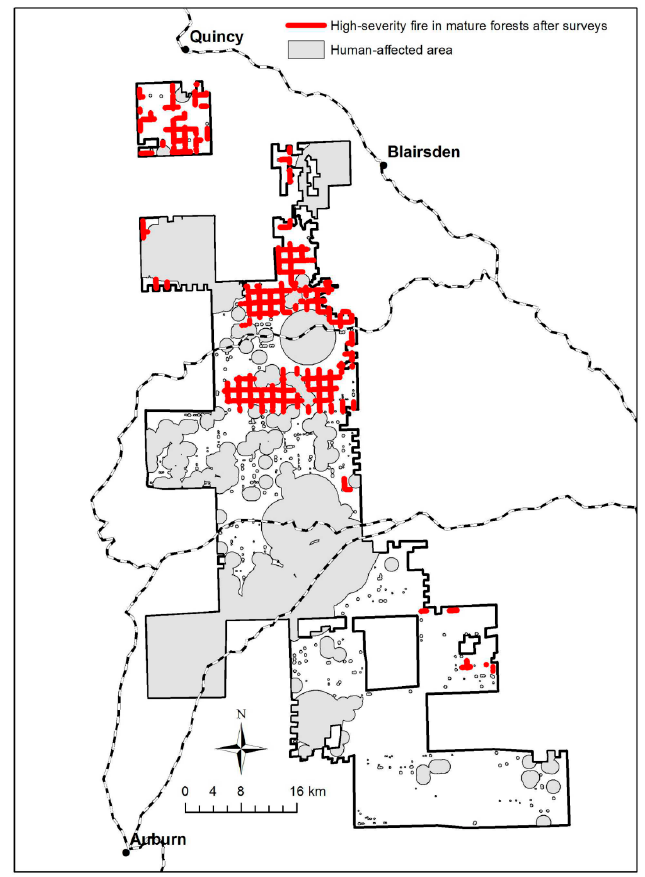
Figure 5. Areas of mature Sierran mixed-conifer forest burned at high severity after the surveys and before Leiberg’s mapping ca 1900 [38]. The Leiberg 75–100% burned category from 1900 was overlain on the survey section-line data from 1865 to 1890. Section lines shown in red were described by surveyors as “heavily timbered,” “good timber,” or “excellent timber,” and thus as mature forest in 1865–1890 before Leiberg mapped these areas in 1900 as severely burned. Reprinted from Baker ([28] Figure 8) with permission from John Wiley and Sons.